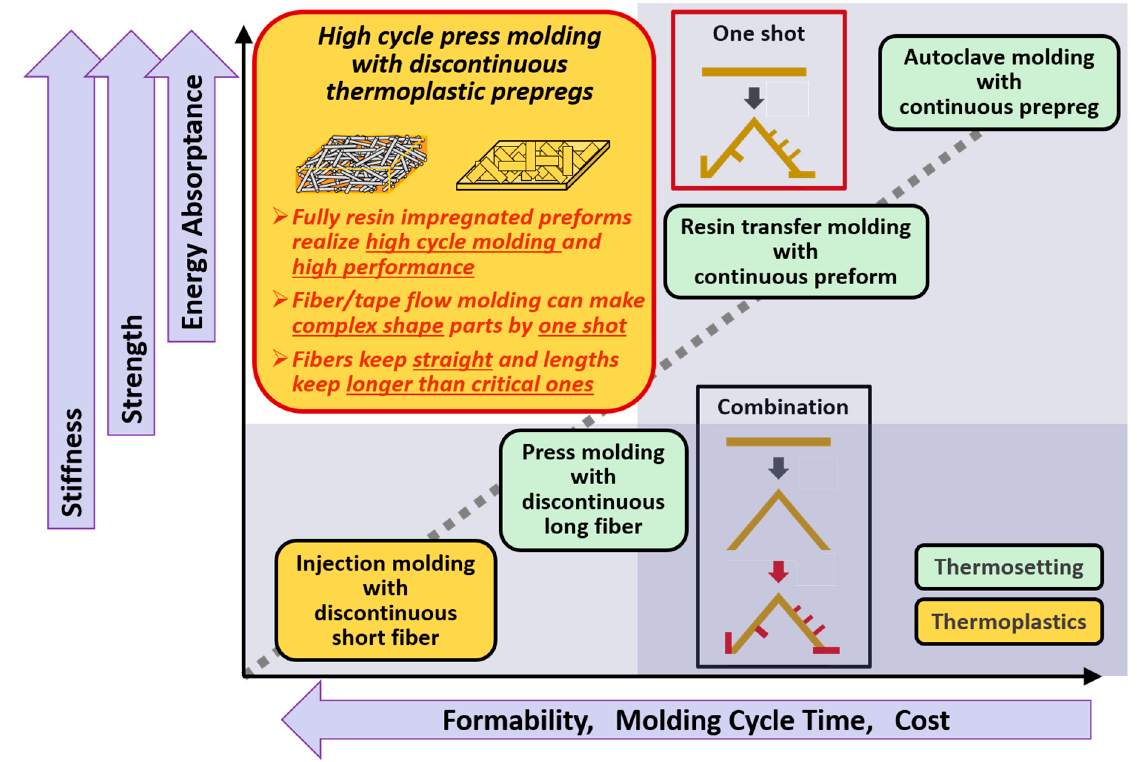
Figure 2. Development direction of carbon fiber-reinforced thermoplastics (CFRTPs) in projects aiming to realize high- performance, affordable, formable, and recyclable components [4].